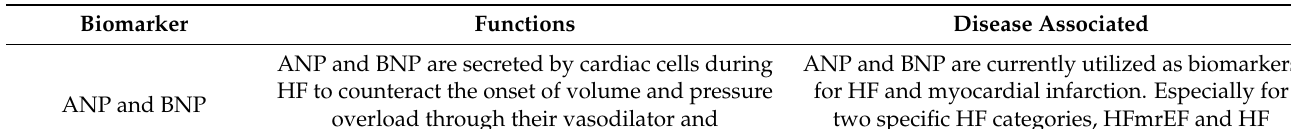
Table 2. Biomarkers associated with